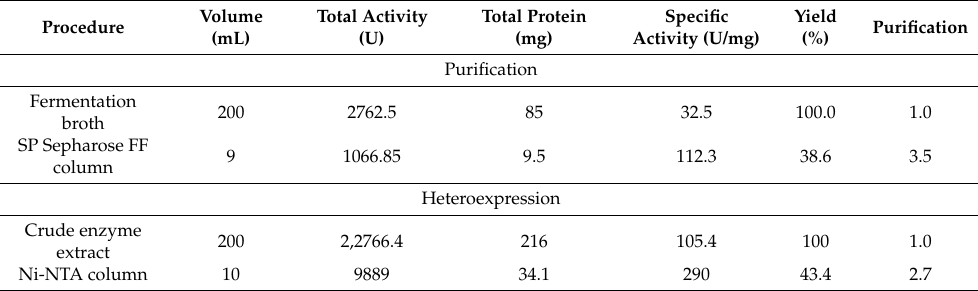
Table 2. Purification of P. polymyxa KF-1 Pel10a and of recombinant PpPel10a from E. coli